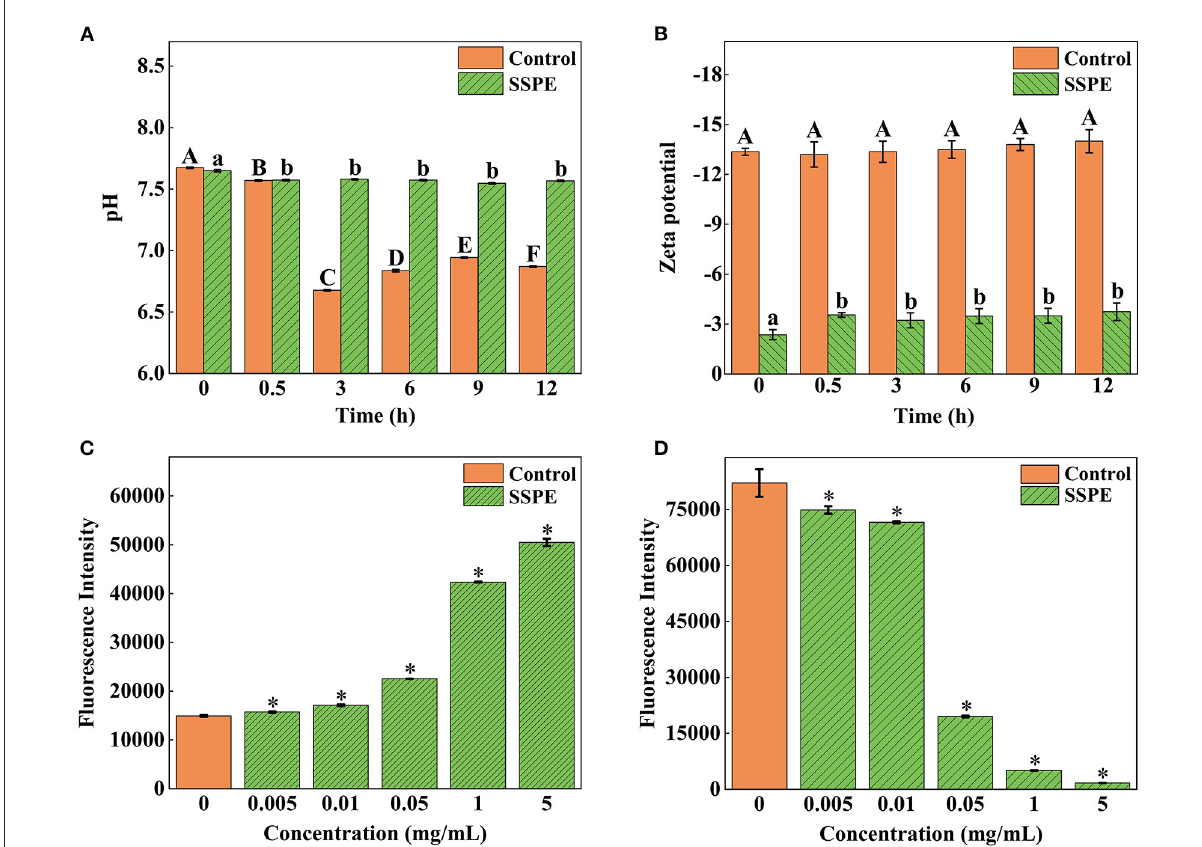
FIGURE5 Effects of SSPE on the pH (A) , zeta potential (B) , membrane potential (C) and intracellular ATP concentration (D) of E. coli . Control: untreated with SSPE; SSPE: treated with 1 mg/mL SSPE. Different capital letters and lowercase letters indicate that the results are significantly different in the same group at different time ( p < 0.05); *indicates significant difference between treatment group and untreated group (control group) in fluorescence intensity ( p <